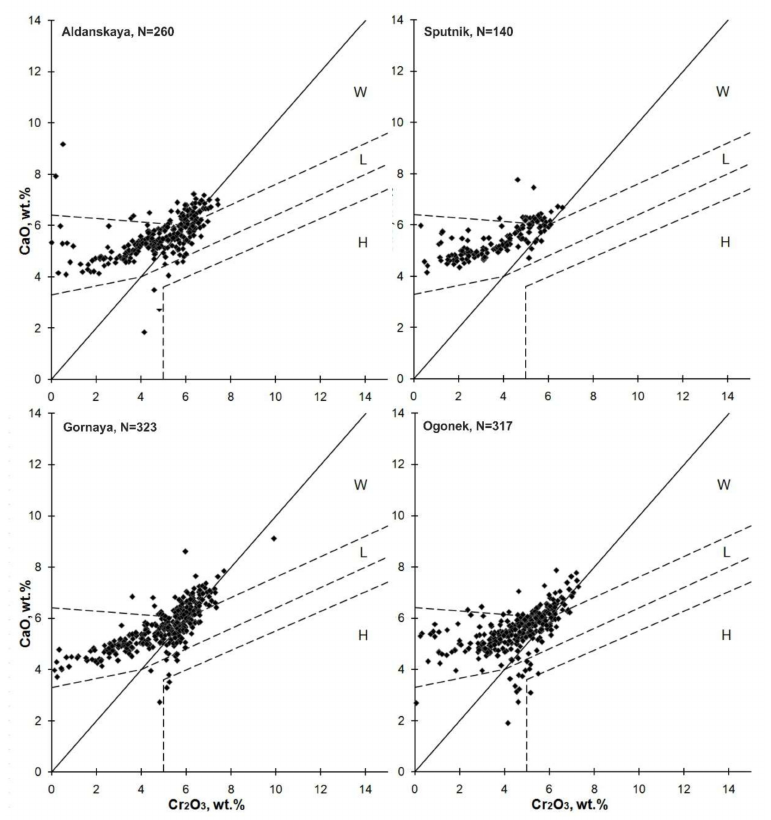
Figure 7. Cr 2 O 3 (wt%) vs. CaO (wt%) correlation in pyrope garnets from Aldanskaya dyke